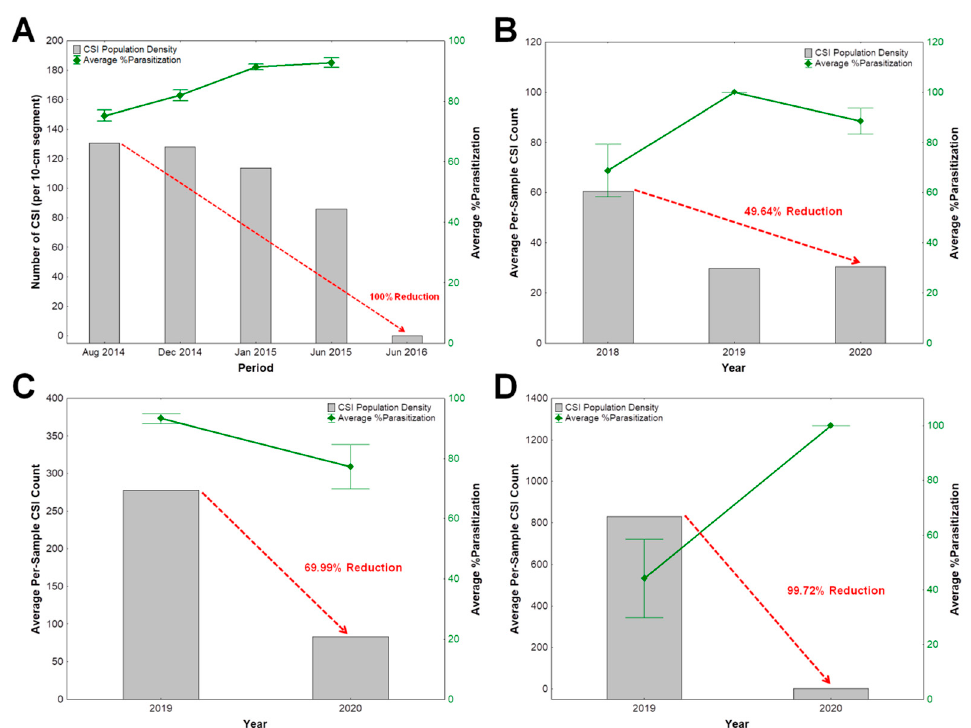
Figure 6. Population density of Aspidiotus rigidus and percent parasitization by Comperiella calauanica over time in: ( A ) Southern Tagalog from August 2014 to June 2016; ( B ) Zamboanaga Sibugay from 2018 to 2020; ( C ) Zamboanga City, and ( D ) Isabela City from 2019 to 2020. Columns represent averages of pooled scale insect population counts from all the trees sampled for a particular period.